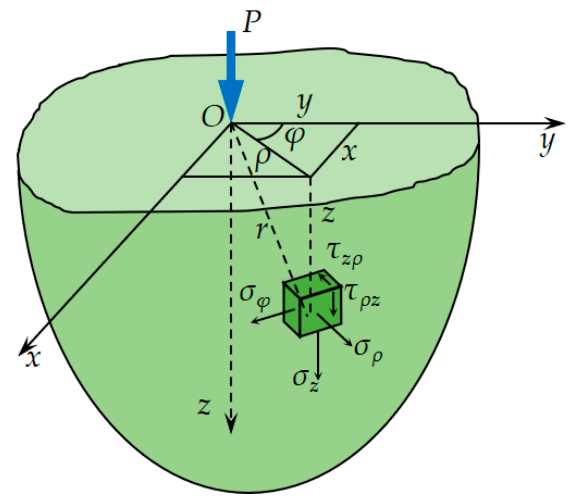
Figure 5. An elastic half-space subjected to a concentrated force, P ; r is the distance between the element and the origin of the coordinate. The coordinates of the element are ( ρ , φ , and z ).